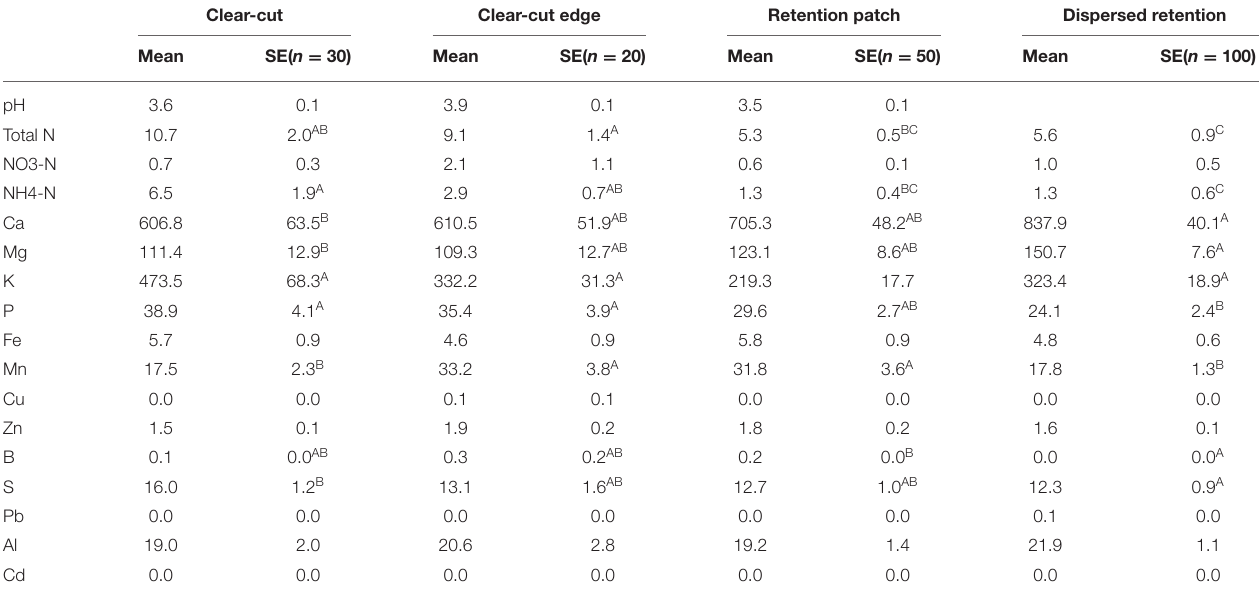
TABLE 2 | pH and soil nutrient availability (top 10cm) in the clear-cut treatment, the clear-cut edge treatment (within 9m of the retention patch), the retention patch and the dispersed-retention treatment as estimated using PRS probes. Clear-cut Clear-cut edge Retention patch Dispersed